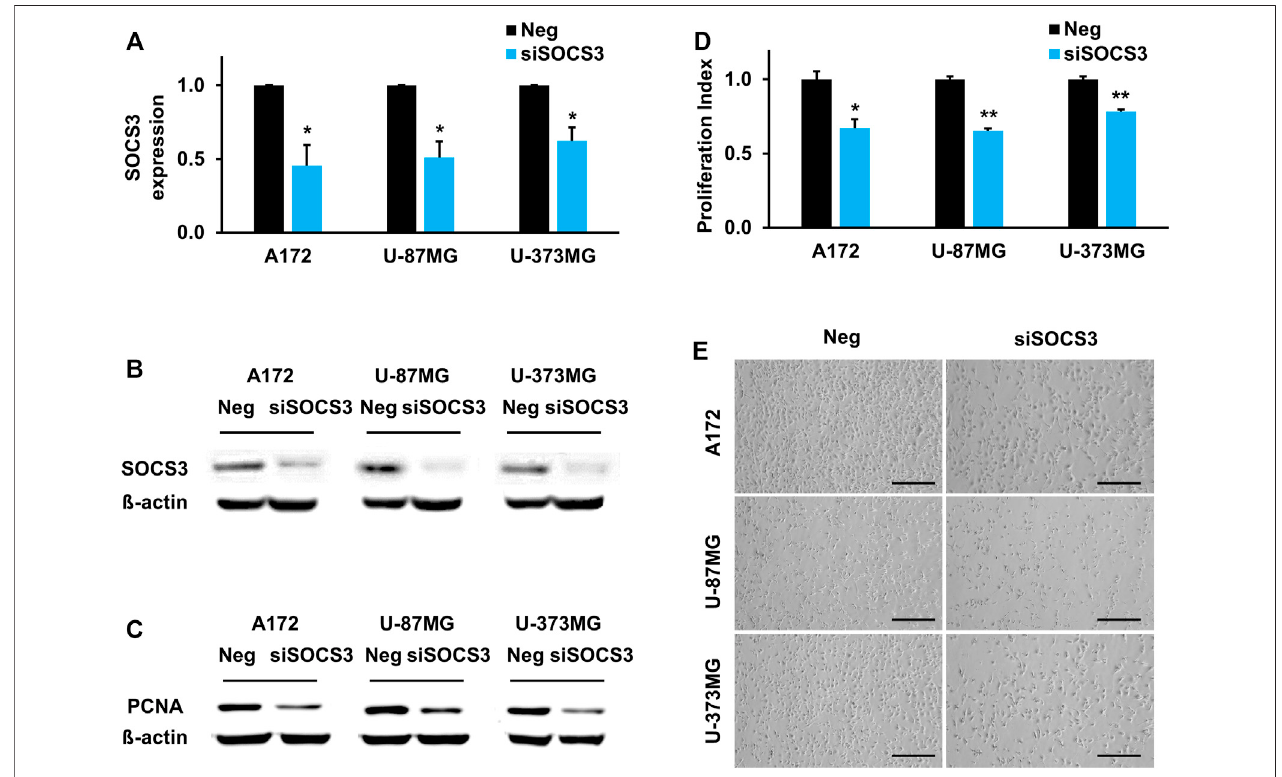
FIGURE 5| SOCS3 governs brain development by regulating proliferation capacity. (A,B) Downregulated SOCS3 expression levels upon transfecting siSOCS3 in human GBM cell lines. (C) Comparison of PCNA expression after siSOCS3 transfection by western blot analysis. (D) Measurement of cell proliferation rate and corresponding images. Scale bars, 100